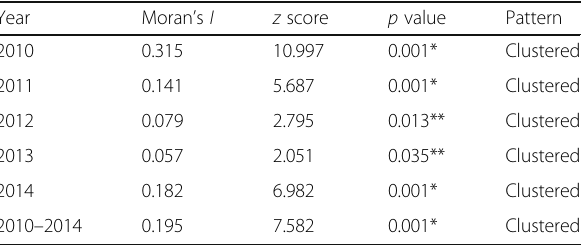
Table 1 Global autocorrelation of VL (2010 – 2014)